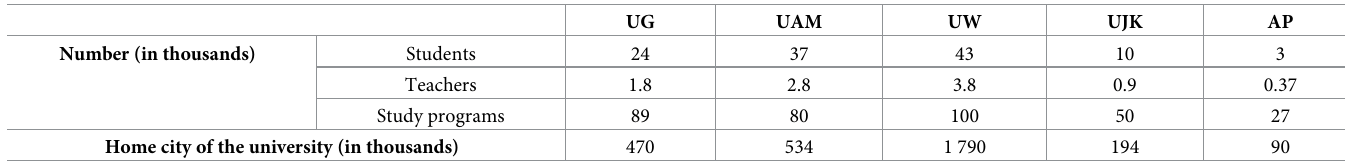
Table 2. Characteristics of the universities most widely represented in the current